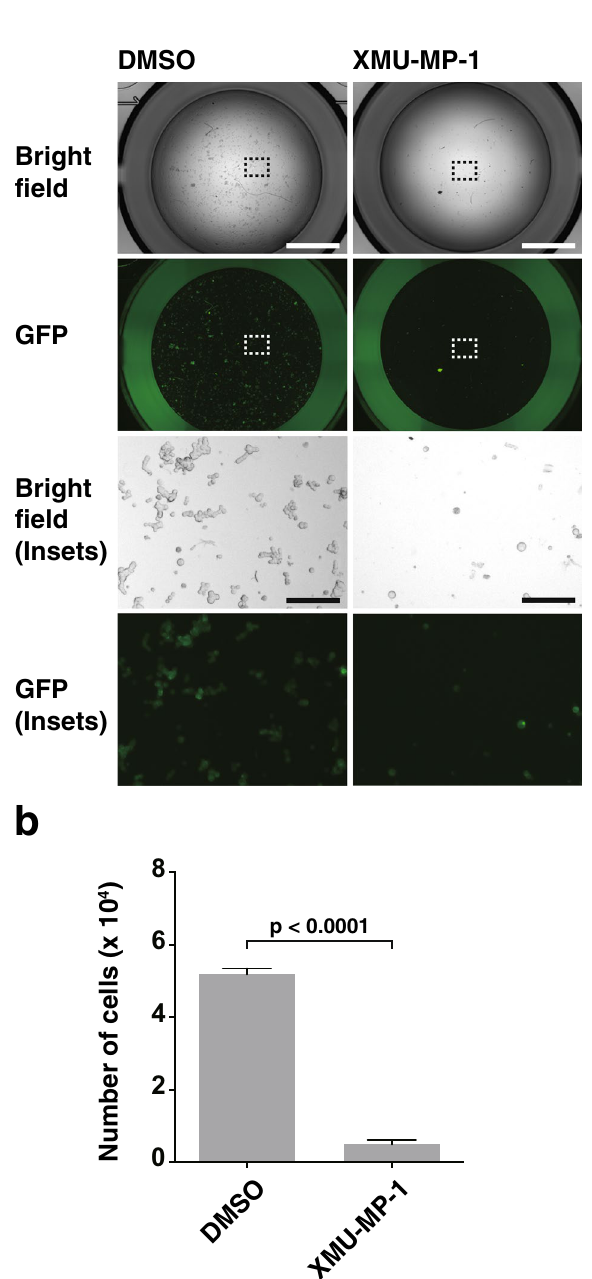
Figure 6. YAP inactivation-dependent enhancement of T47D cell proliferation by nectin-4 and p95-ErbB2 in a suspension culture. ( a , b ) Requirement of the MST1/2 activation for the enhancement of T47D cell proliferation in a suspension culture by nectin-4 and p95-ErbB2. The T47D cells stably expressing GFP-tagged p95-ErbB2 (p95-ErbB2-GFP) with FLAG-tagged nectin-4 (FLAG-Nectin-4) were detached using Accutase. The cells were collected, their numbers were counted, and the same numbers of the cells were seeded in serum-free medium with supplements on ultra-low attachment 6 well dish. After the incubation with the MST1/2 inhibitor XMU-MP-1 at 1 μM for 28 days, the cells were collected and transferred to ultra-low attachment 96 well dish for image acquisition. Then, the cells were re-collected and subjected to quantitative analysis by cell counting as shown in ( b ). The displayed images were acquired using a BZ-X710 microscope and its software BZ-X Analyzer (https:// www. keyen ce. co. jp/ produ cts/ micro scope/ fluor escen ce- micro scope/ bz- x700/ models/ bz- x710/) with BZ-H3A Advanced Application software (https:// www. keyen ce. co. jp/ produ cts/ micro scope/ fluor escen ce- micro scope/ bz- x700/ models/ bz- h3a/) for image connection. The T47D cells stably expressing p95-ErbB2-GFP with FLAG-Nectin-4 used in the experiments were the bulk of collected cells and not singly picked-up clones. Bars indicate the means ± S.D. of three independent experiments and the actual P value is shown in each figure. Scale bars 2000 μm or 200 μm (insets). Representative results (images) from three independent experiments were